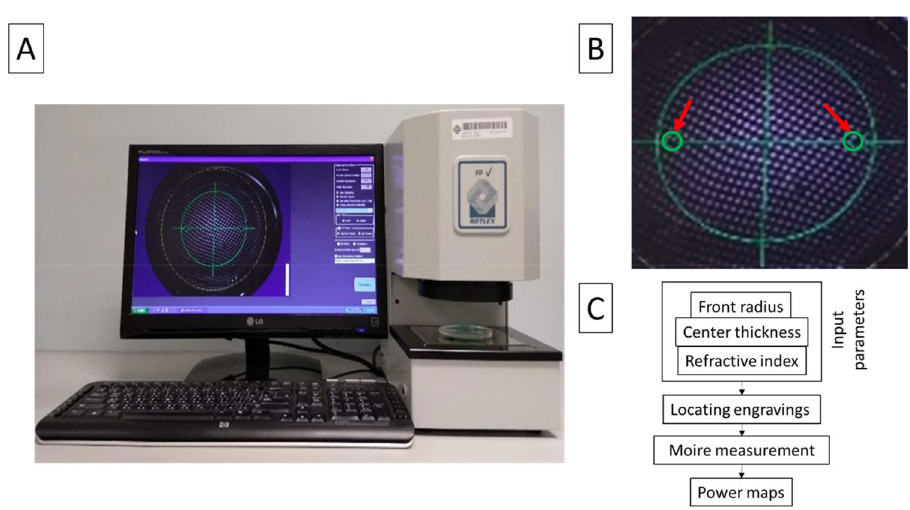
Figure 1. Measurement of refractive power profile. ( A ) The Rotlex Free Form Verifier system with graphic user interface (left) and positioning device (right). Note that the tested PAL was set with the front surface facing downwards. ( B ) The two standard engraved symbols of the PAL marked with a fine-tip marker and positioned within the green rings (arrows) appeared on the graphic user interface. ( C ) The flow chart summarizes the measurement